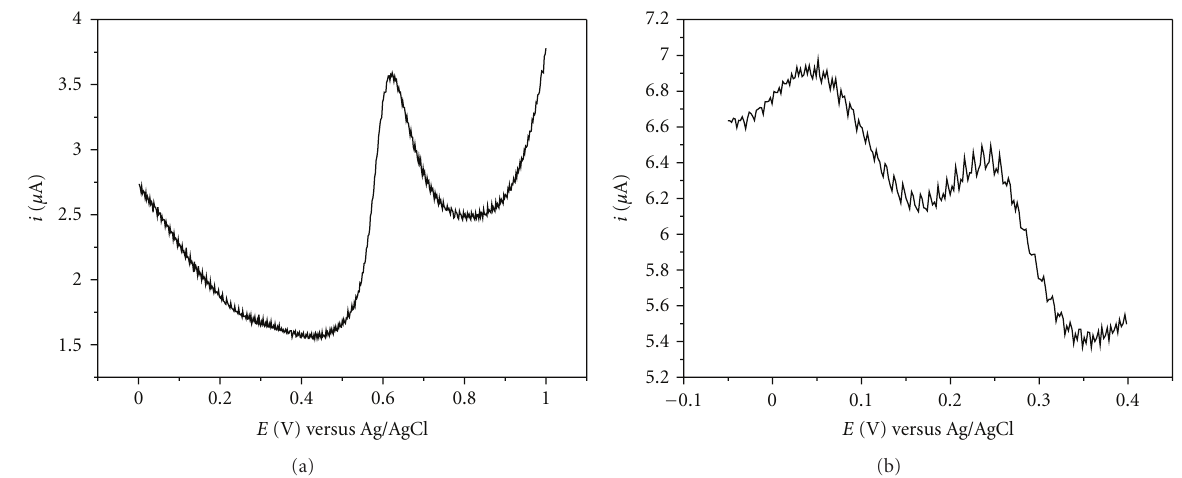
Figure 3: Square wave voltammograms obtained at the 60% (w/w) carbon nanotube paste electrode using 3 . 0 × 10 − 4 M acetylthiocholine iodide solution in phosphate bu ff er pH 7.4 (a) and thiocholine (b). Δ E p = 50mV, Δ E s = 2mV, and f = 50 Hz.